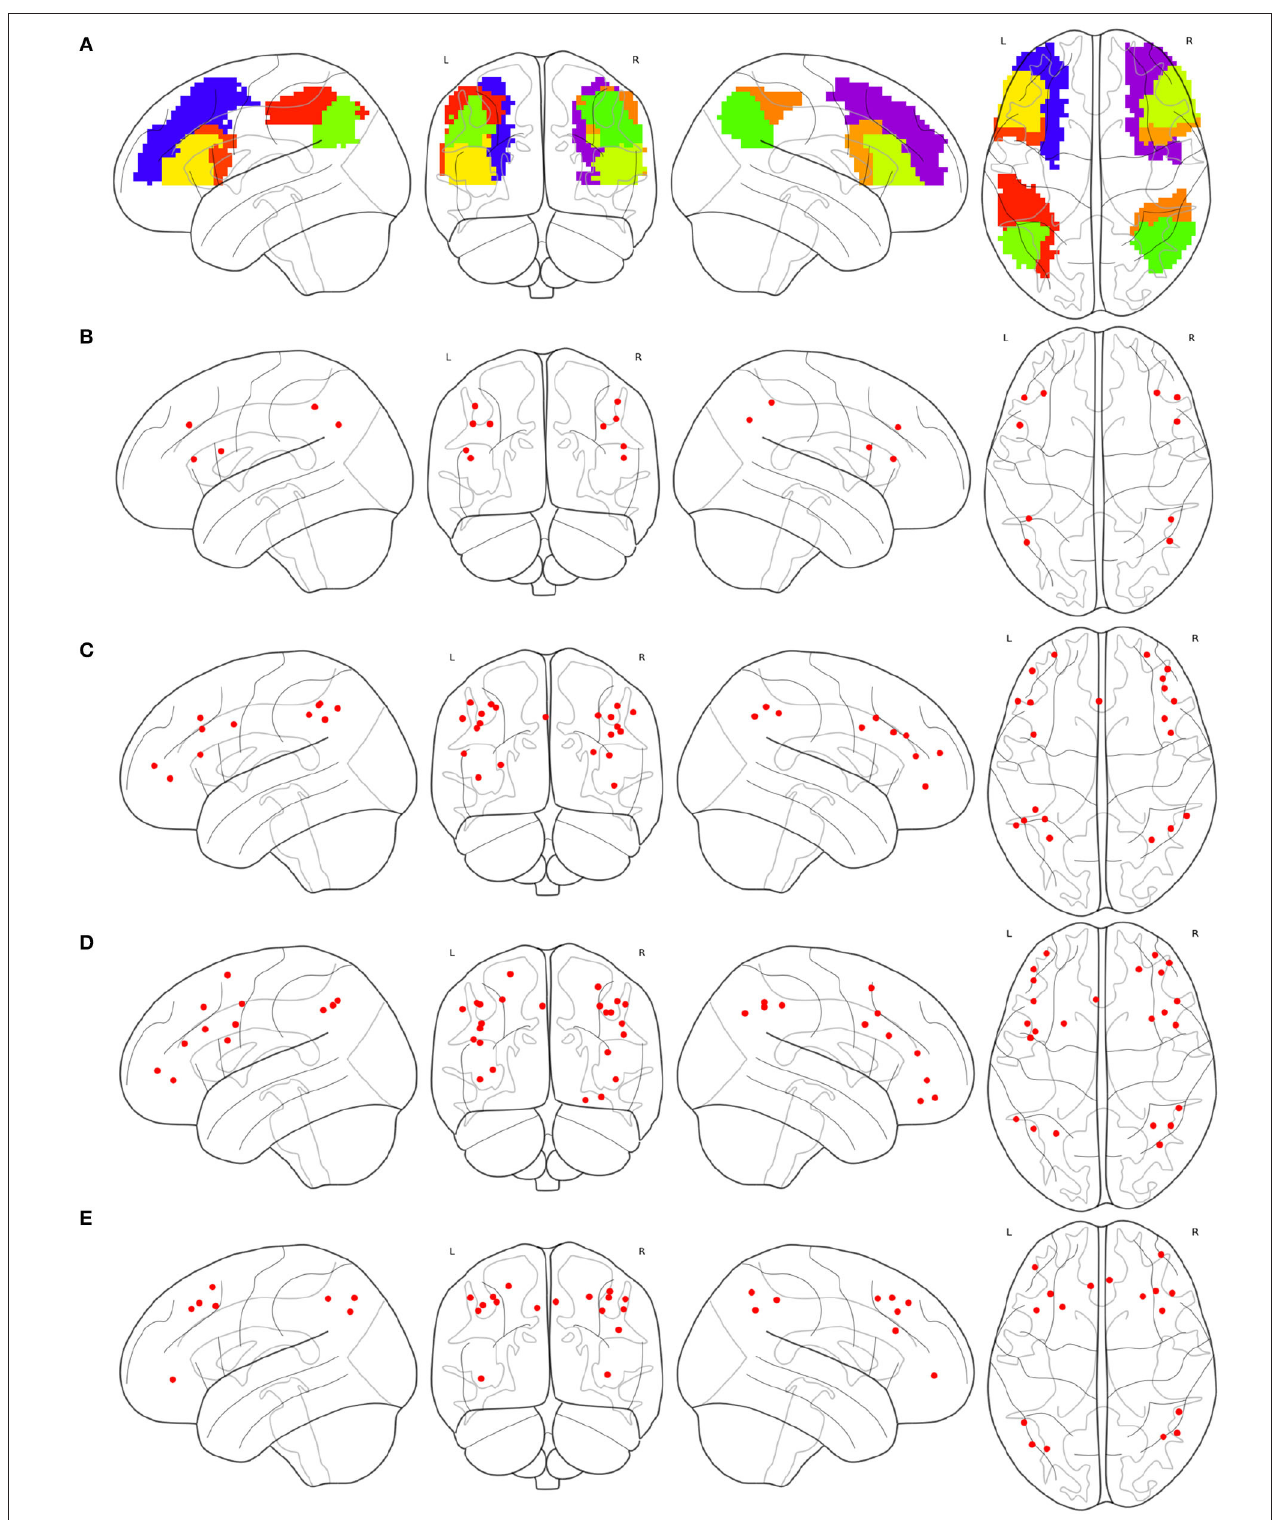
FIGURE 3 | Multi-source FPNs for synthesizing the combined FPN, (A) the regions belong to the FPN of AAL, (B) 10 ROIs of the FPN in AAL, (C) 21 ROIs of the FPN in Dosenbach-160, (D) 24 ROIs of the FPN in Power-264, and (E) 17 ROIs of the FPN in Willard-499.